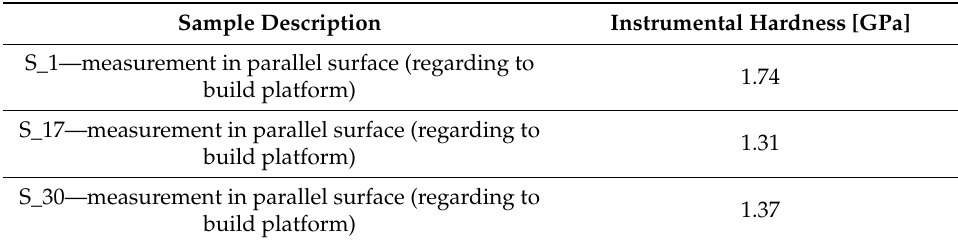
Table 4. Instrumental hardness of samples S_1, S_17, and S_30.